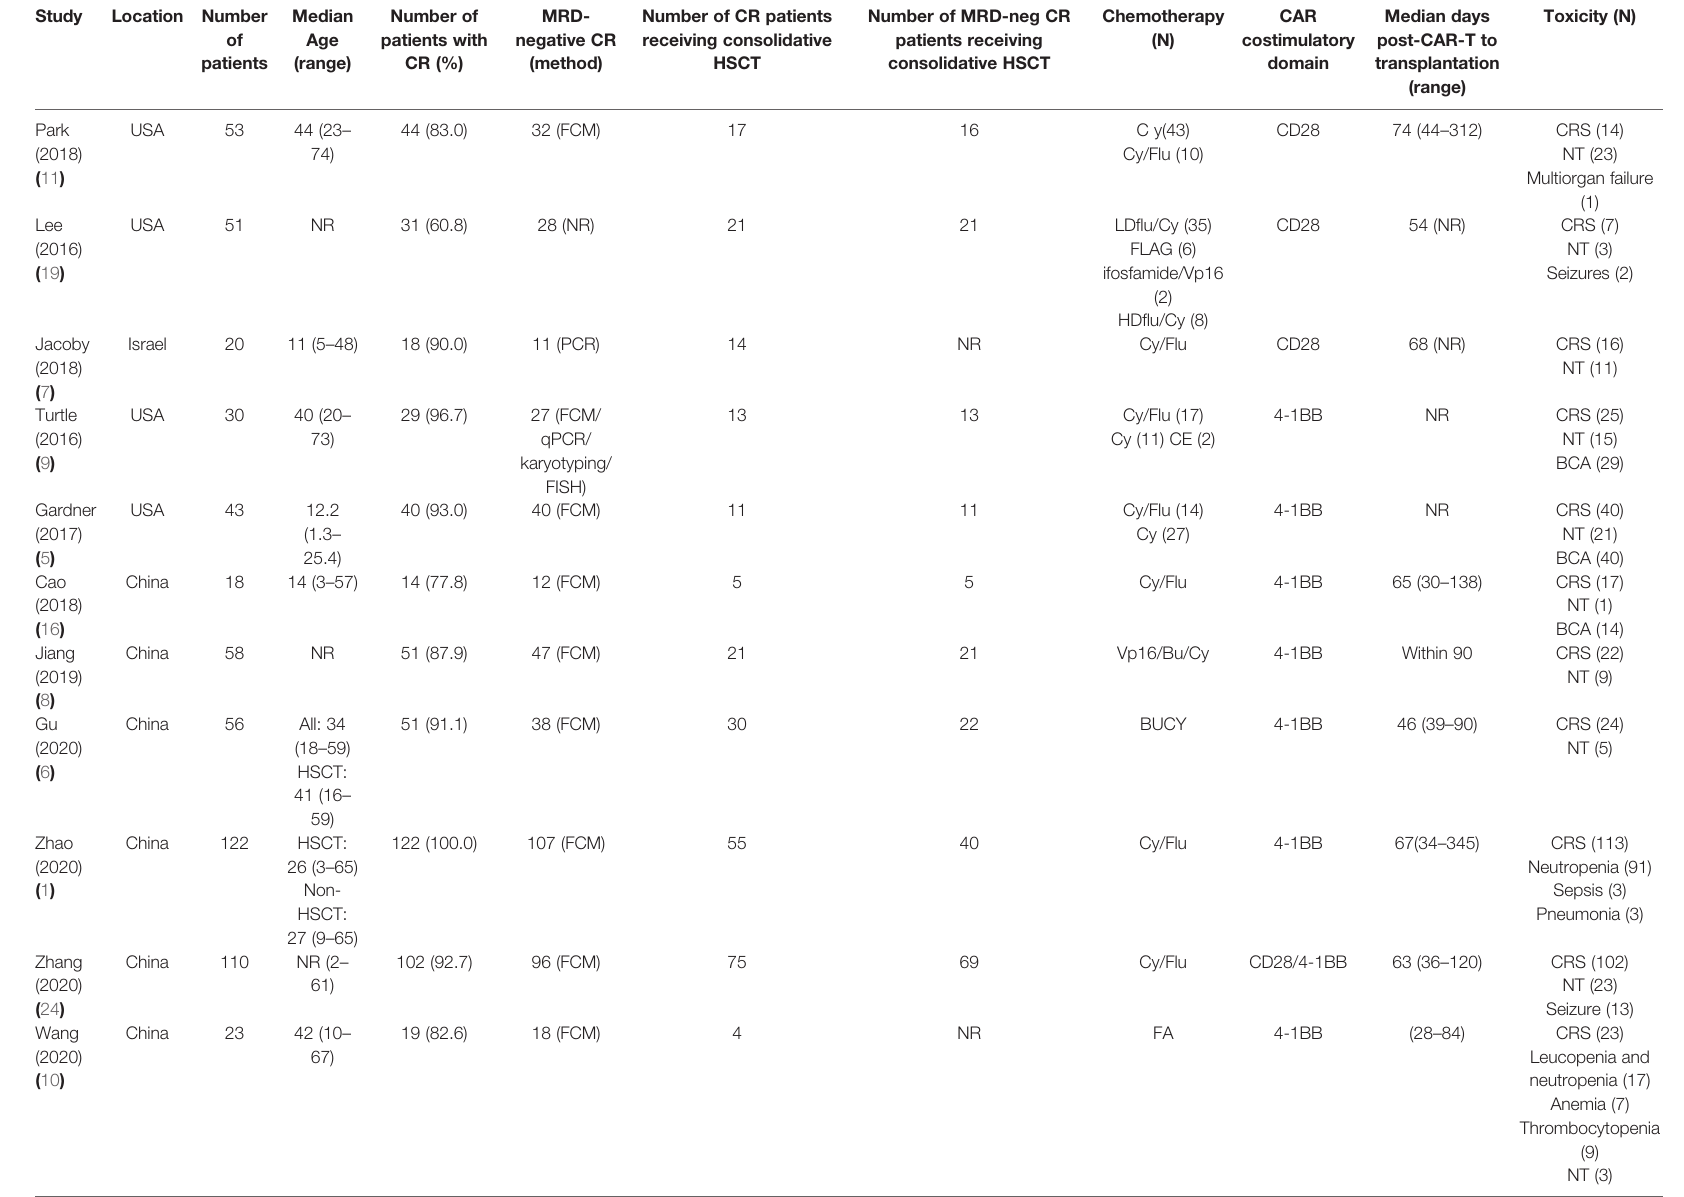
TABLE 1 | Characteristics of the included studies with ef fi cacy